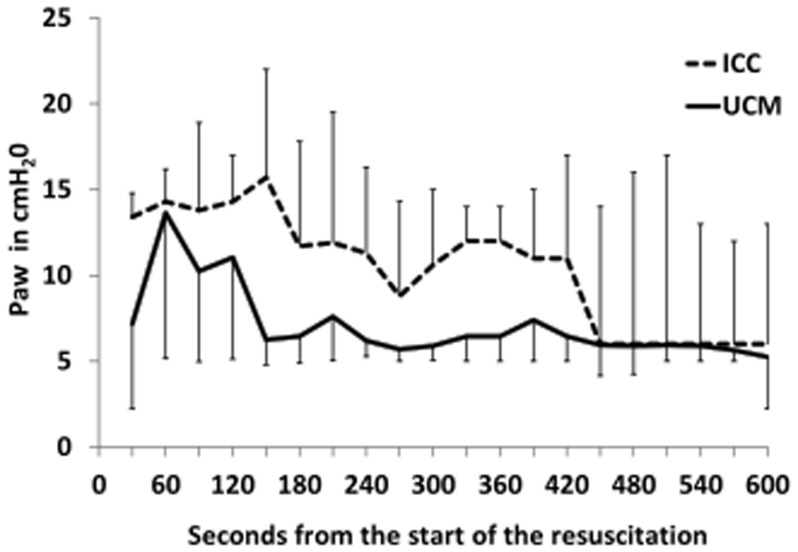
Changes in mean airway pressure (MAP) over time in infants receiving umbilical cord milking (UCM) compared to immediate cord clamping (ICC).During the first five minutes of resuscitation, there was a non-significant trend towards a lower mean airway pressure requirement in infants in the UCM (ANOVA, P = 0.13).